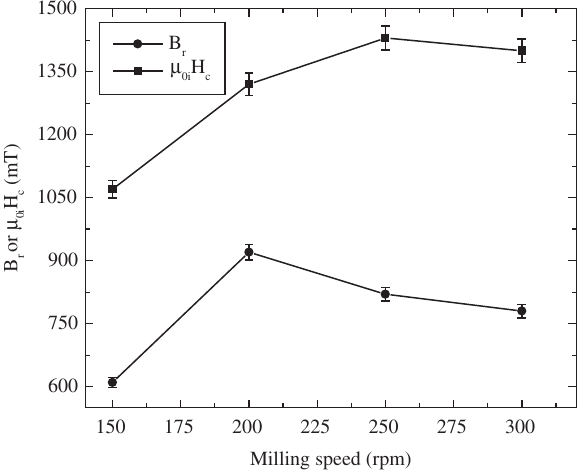
Figure 4. Variation of remanence and intrinsic coercivity with milling speed for 2.7 ks milling